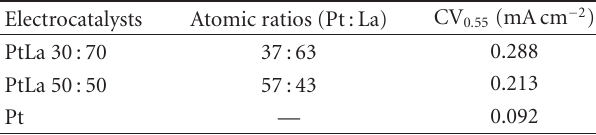
Table 1: Pt: La ratios from EDX analysis and current density from chronoamperometric curves obtained at 0.55